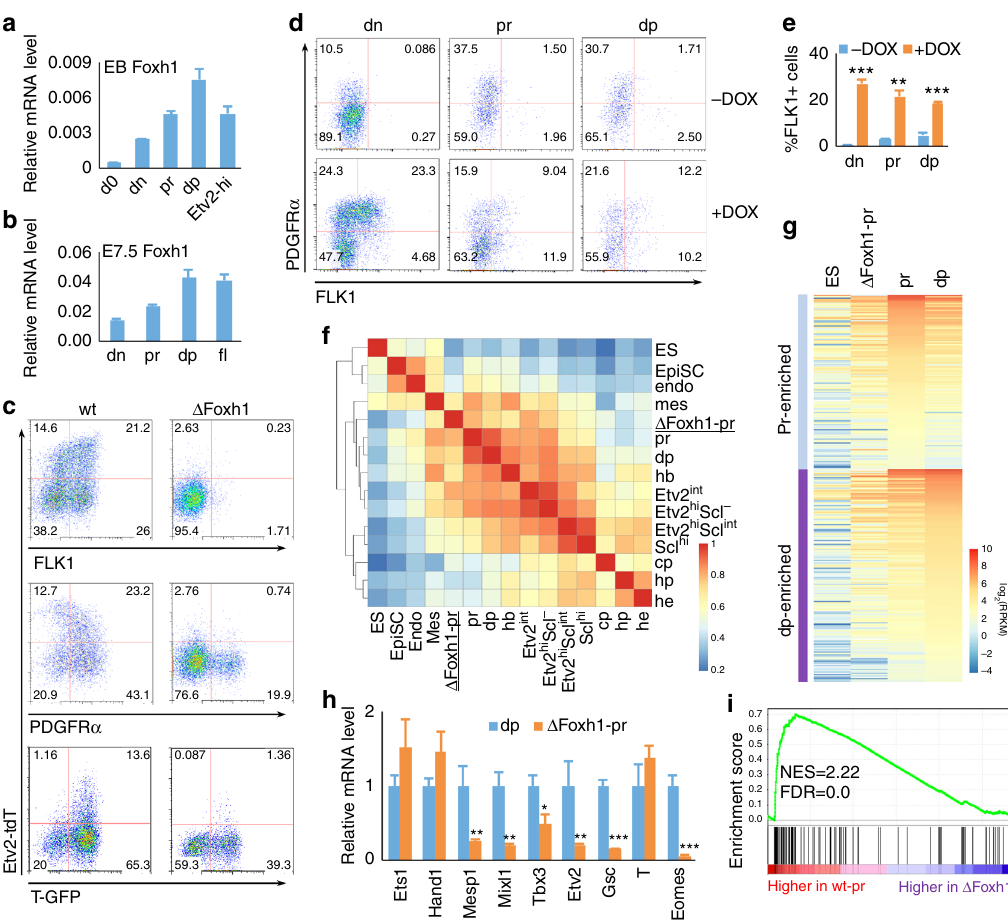
Fig. 4 Foxh1 is required for FLK1 + mesoderm generation. a Relative mRNA levels of Foxh1 in indicated cell populations sorted from D4 EBs are shown. b Relative mRNA levels of Foxh1 in indicated cell populations sorted from E7.5 embryos are shown. c FACS analysis of D4 wild type ( wt ) and Δ Foxh1 EB cells is shown. ( Top and middle , SGET cells; bottom , TGET cells). d iFoxh1- Δ Foxh1 cells were differentiated with 500 ng/mL DOX, “ dn ” , “ pr ” and “ dp ” cells were sorted on D3, and re-seeded onto OP9 cells with or without 500 ng/mL of DOX. Cells were analyzed 24 h later by fl ow cytometry. The results are summarized in e . f Spearman correlation map of RNA-seq data of transcription-related factors from indicated populations. g Comparison of RNA-seq results of “ pr- ” or “ dp ” -enriched genes in Δ Foxh1 “ pr ” , wt “ pr ” , “ dp ” , and undifferentiated ES cells is shown. h Expression of key transcription factors with highest expression in “ dp ” (identi fi ed in Fig. 2g) was validated by qRT-PCR using Δ Foxh1 “ pr ” and wt “ dp ” cells. i GSEA analysis of T-related genes 41 for downregulation in Δ Foxh1 -pr vs. wt-pr cells. Only genes related to T with correlation scores > 0.2 were chosen for GSEA analysis. NES